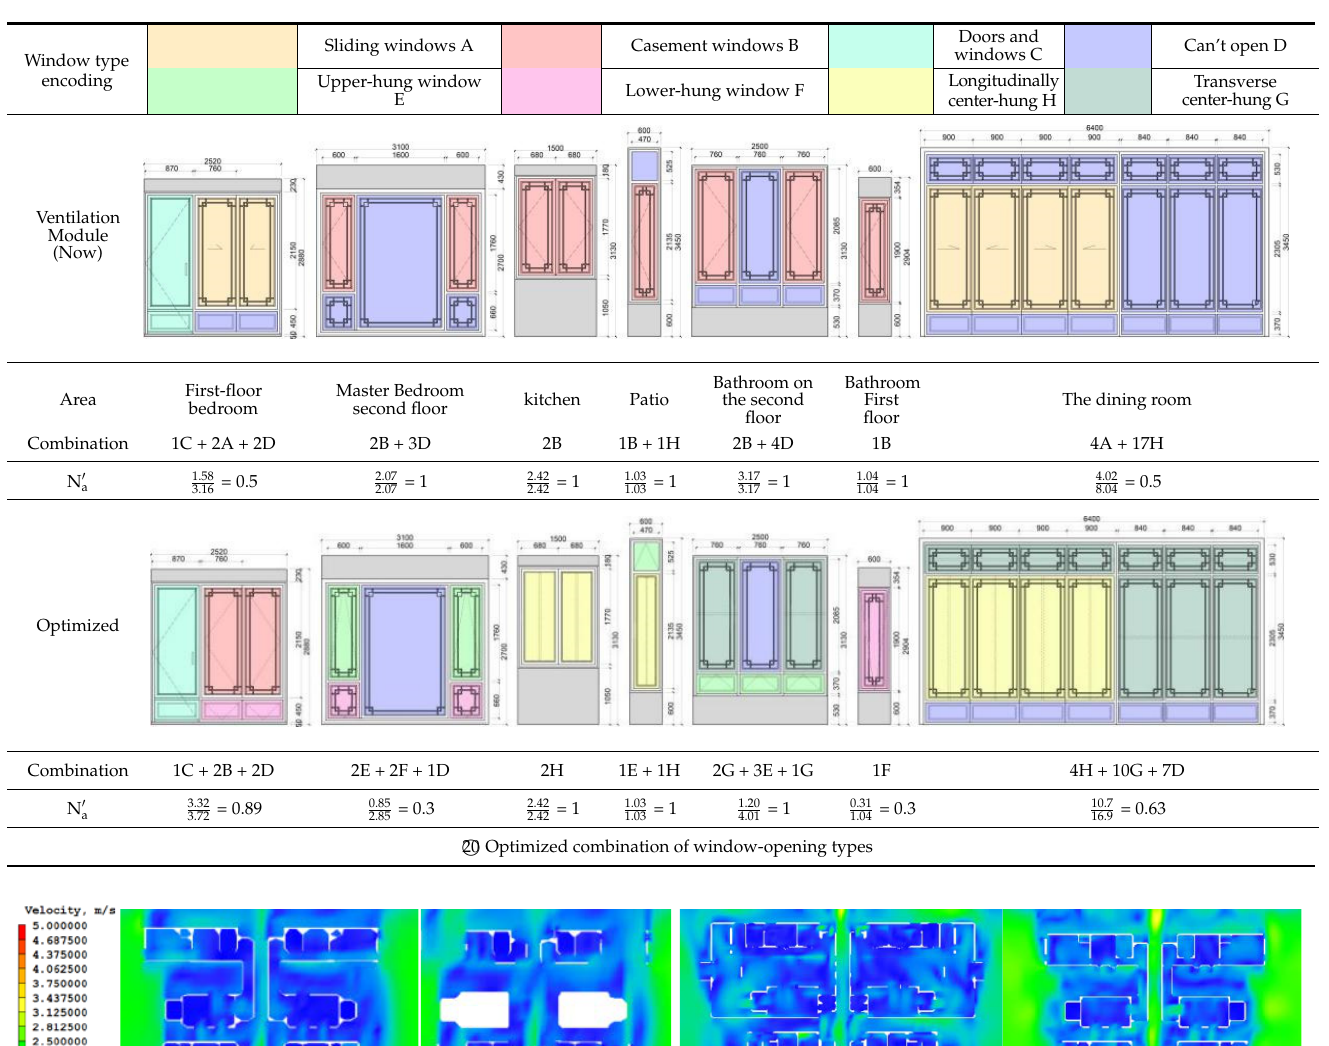
Table 10. Optimization process of window-opening type combination.